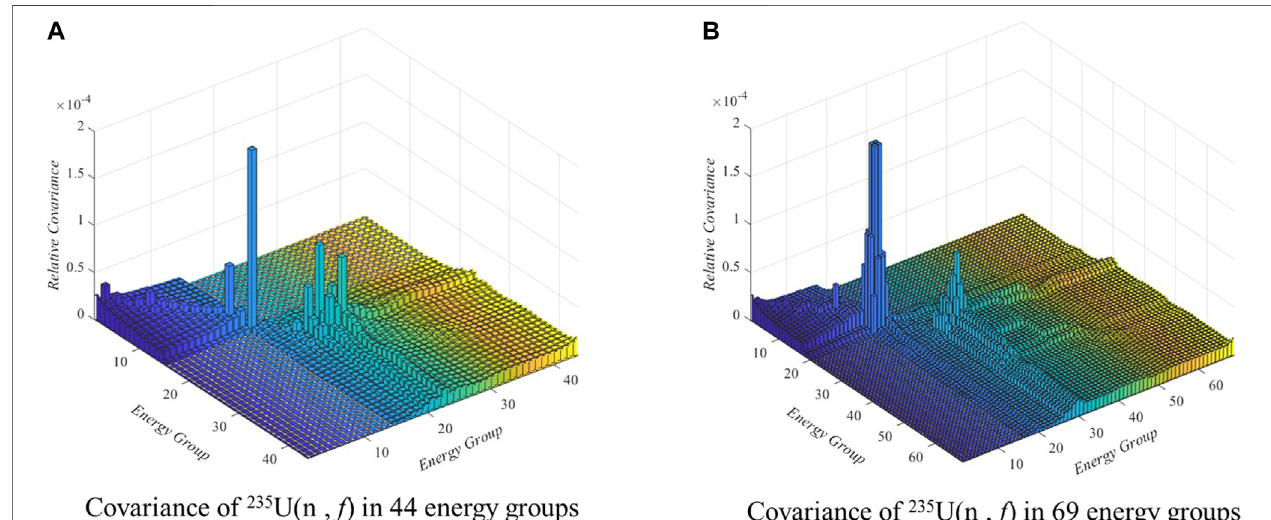
FIGURE 3 | Comparison of relative covariance matrix for 235 U ( n , f